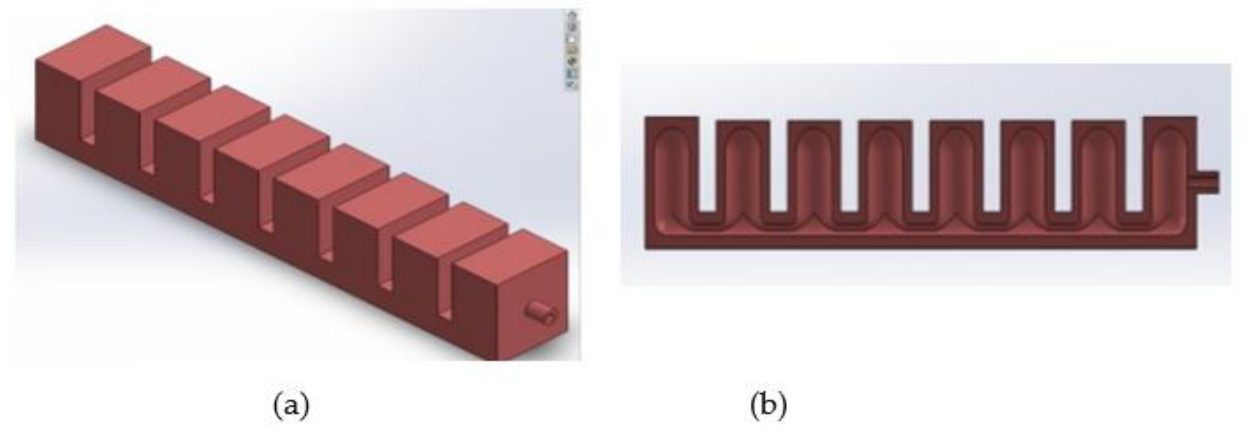
Figure 3. ( a ) Design of soft Pneumatic Actuator; ( b ) Air path in the SPA.